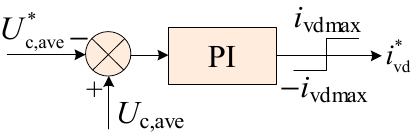
Figure 7. Active power control loop of outer loop controller on output side of M3C.